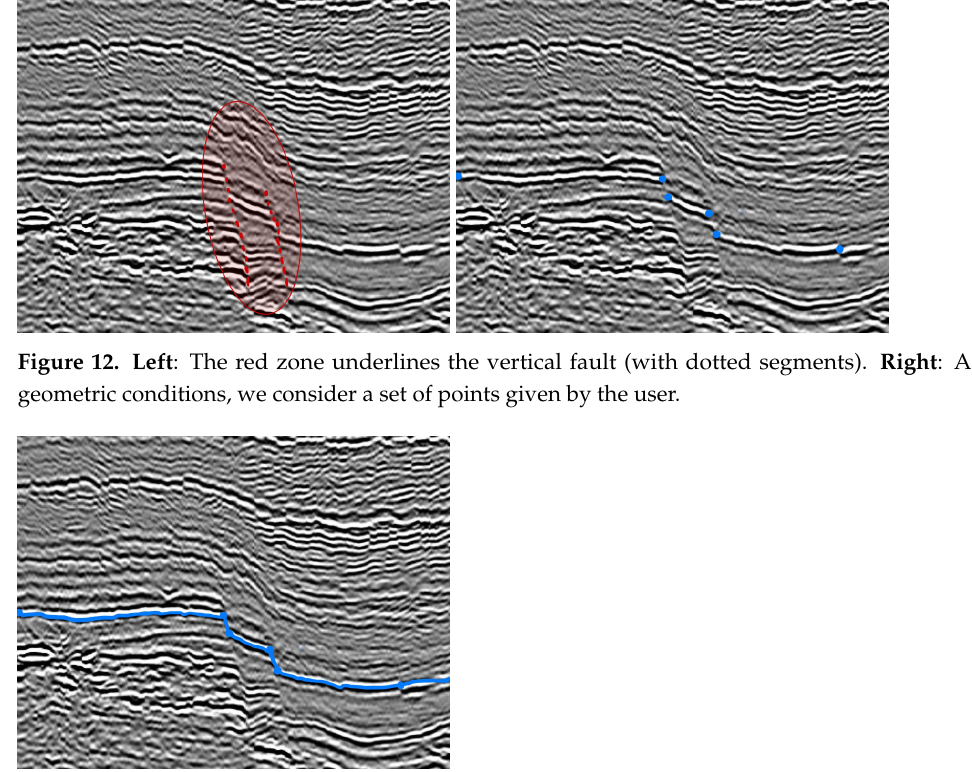
Figure 13. Final result: we can see that the searched layer is correctly segmented. On this specific dataset, the final contour has to reach the edge of the image: the contour goes beyond the last point to interpolate (right side) to join the edge of the